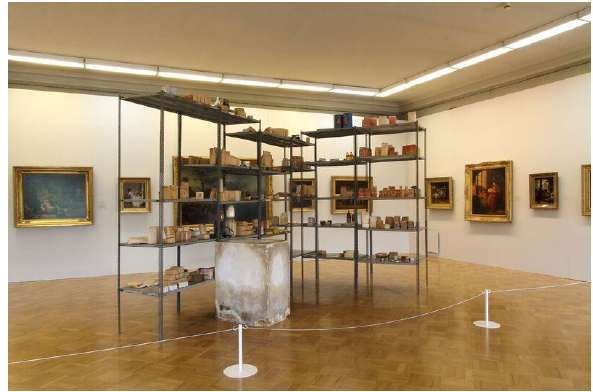
Figure 6 | Joseph Beuys, Economic Values (1980), Collection of S.M.A.K. Stedelijk Museum voor Actuele Kunst, Ghent, Belgium.